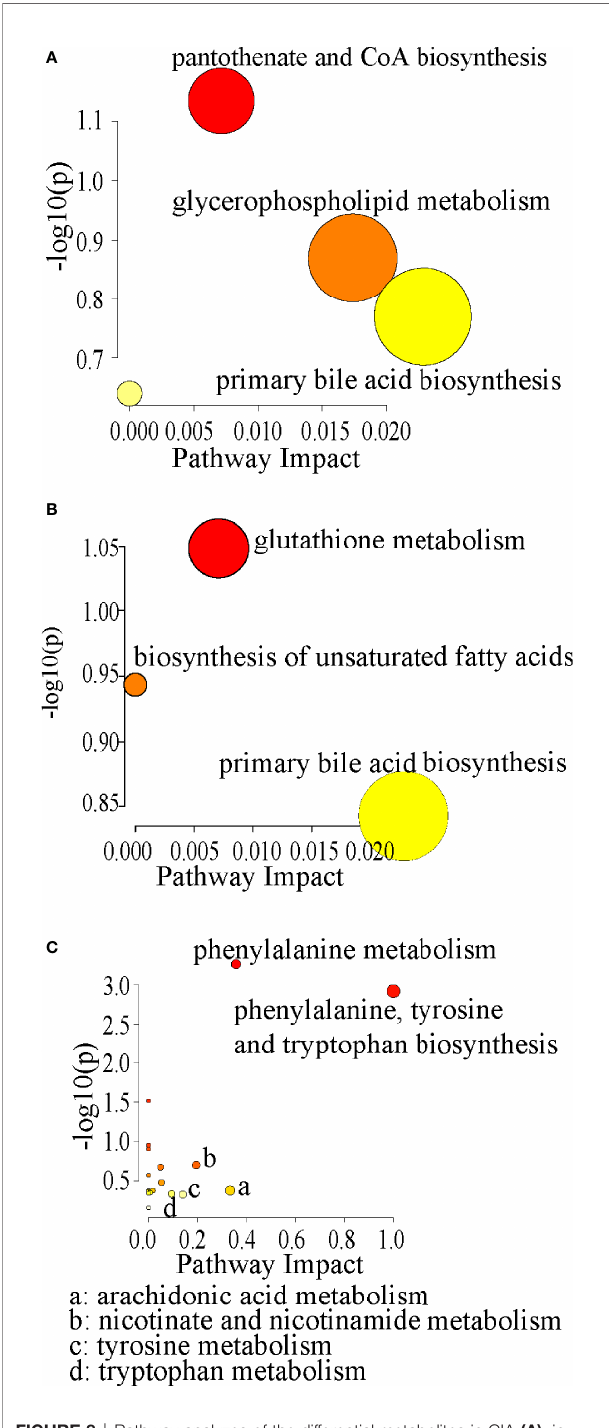
FIGURE 8 | Pathway analyzes of the differential metabolites in CIA (A) , in CCFM1074 (B) and in CCFM1075 (C) . control (vehicle-treated with saline 1.5 mL/day) group, CIA (vehicle-treated with saline 1.5 mL/day) group, methotrexate (MTX)-treated (6 mg/kg/week) group, CCFM1074 (treated